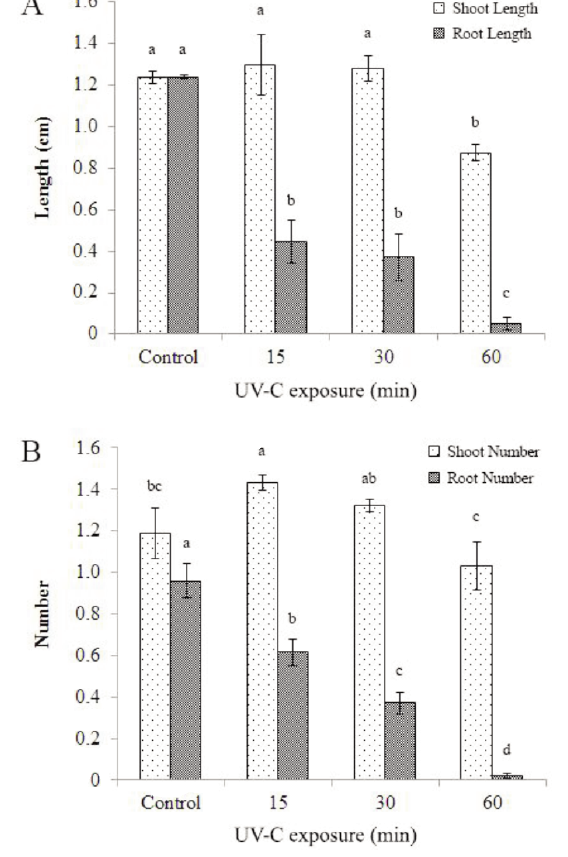
Fig. 1 - Effects of UV-C irradiation on Amsonia orientalis growth parameters. A= length of shoot and root, B= Number of shoot and root. The values are represented as means ± SD, different letters denote significant differences (p<0.05).